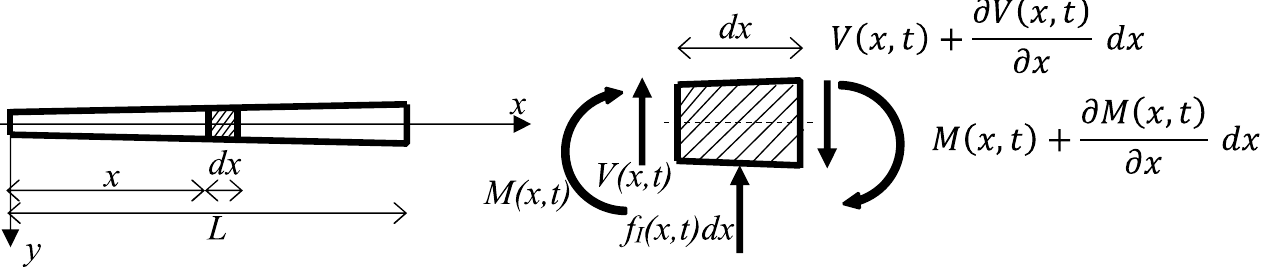
Figure 5. First 5 beam eigenmode shapes.